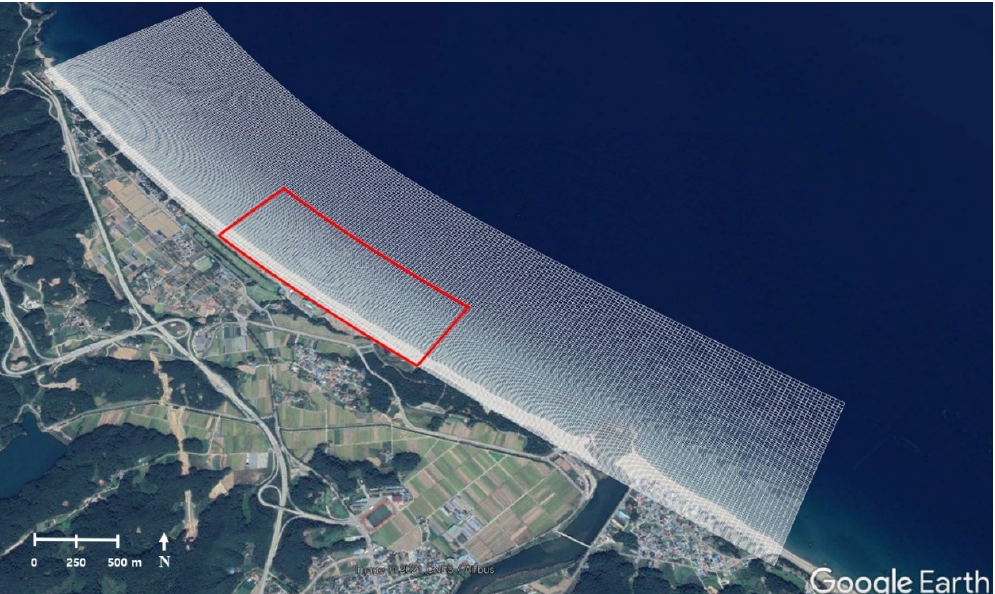
Figure 6. Curvilinear and non-equidistant grid for XBeach modeling (image obtained from Google Earth). The area within the red line, ranging from the landward tip (MSL(+) 6 m) to depth of closure (MSL(-) 10 m) in the cross-shore direction, denotes the location where analysis of bathymetric data and numerical results was performed.